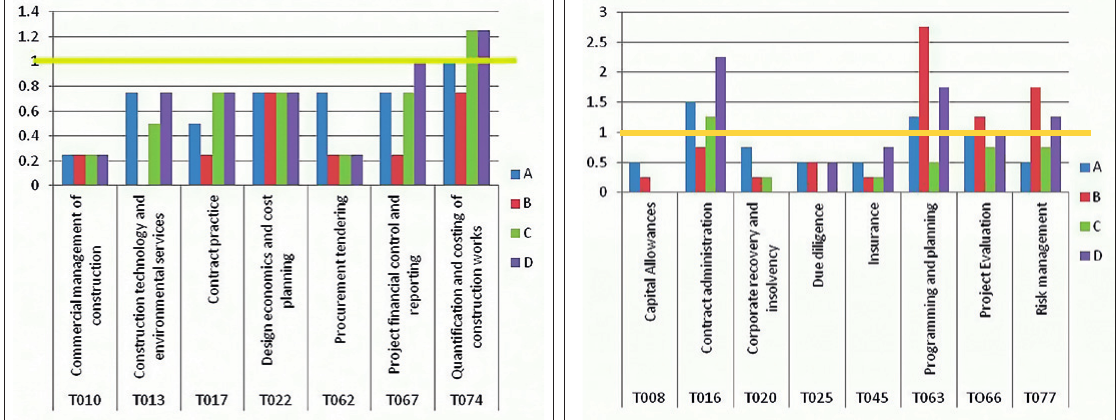
Figure 5. Core competency mapping scores: Figure 6. Optional competency mapping